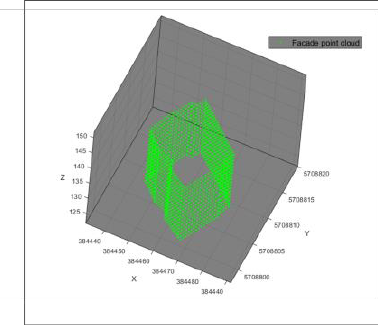
Figure 5 Building facade point